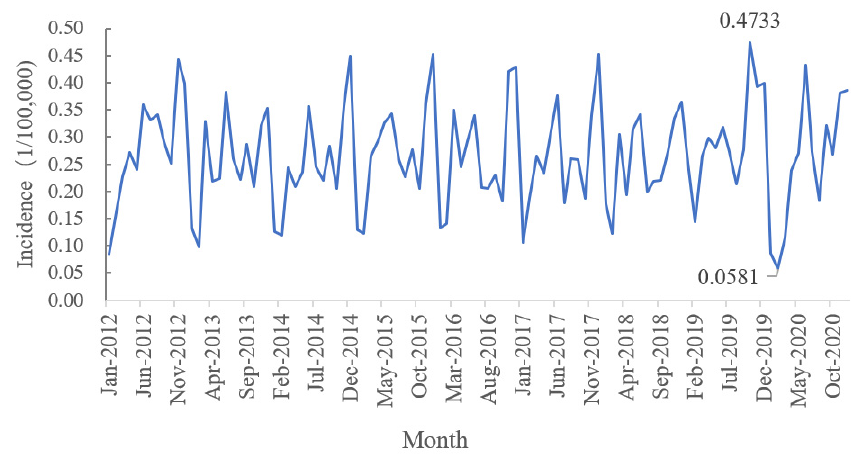
Figure 2. The timeseries diagram of monthly incidence of AIDS in Henan province from 2012 − 2020.